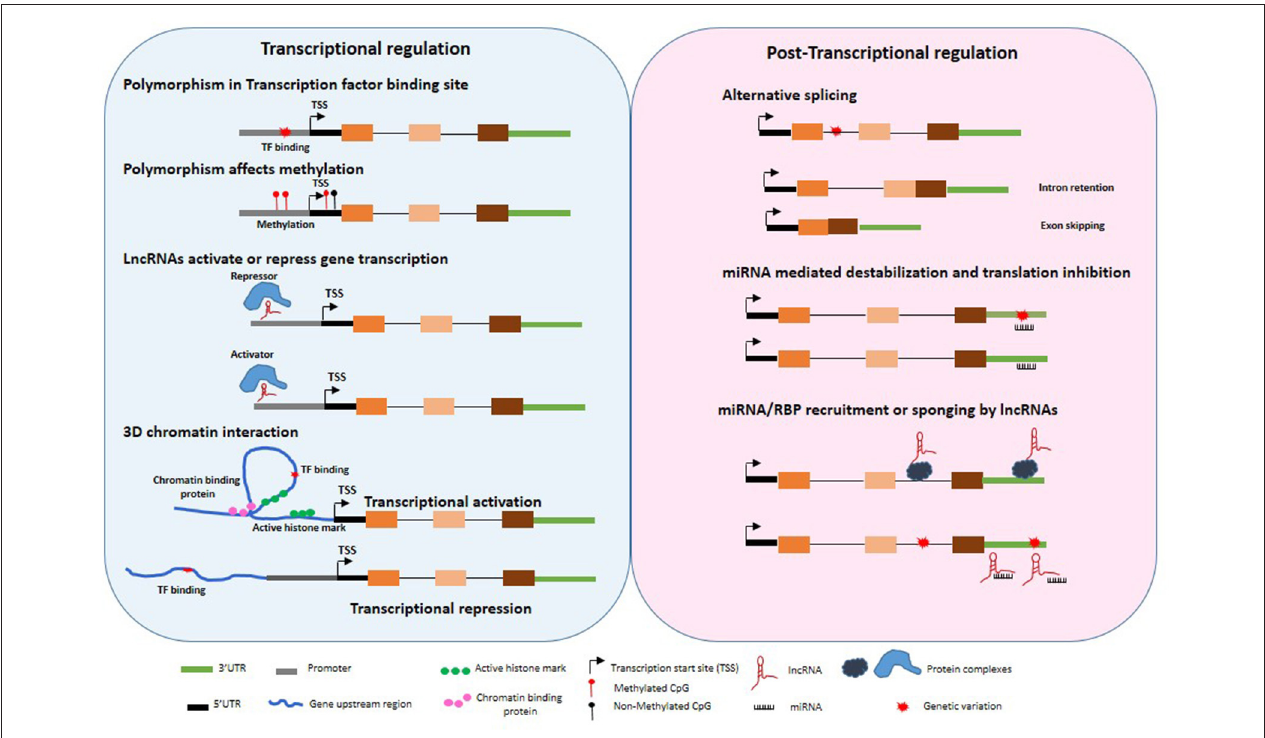
FIGURE 1 | Untranslated gene variations influence regulation of gene expression. Disease associated polymorphisms may alter methylation, transcription factor binding in the gene promoter regions, recruitment of repressor or activators, 3 dimensional chromatin structure, splicing, miRNA binding to 3 ′ UTR, transcriptional and post-transcriptional regulation of target genes through variation in lncRNA expression and